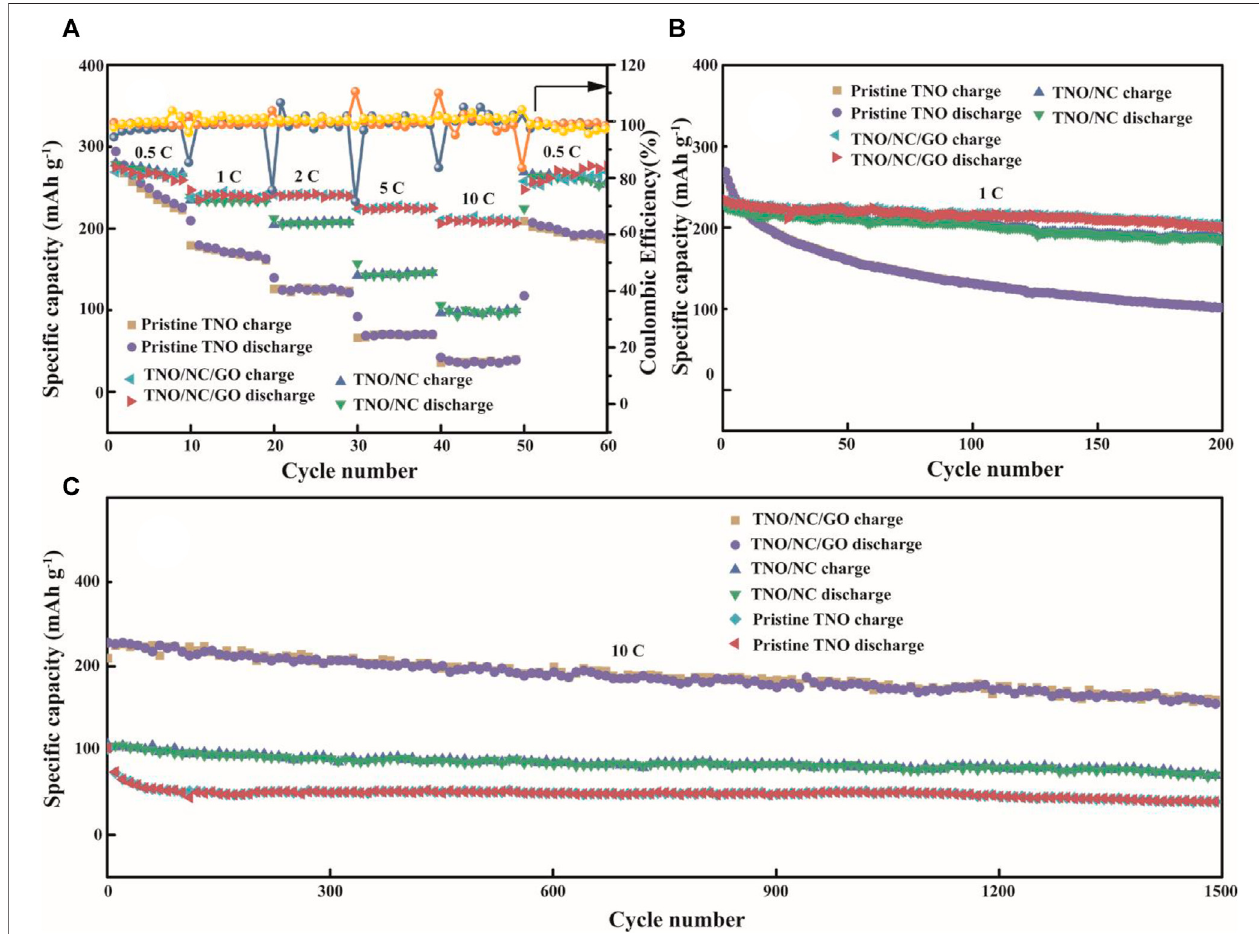
FIGURE 6 | (A) Rate capabilities of pristine TNO, TNO/NC, and TNO/NC/GO at various rates; cycling stability (B) at 1C and (C) at 10C.